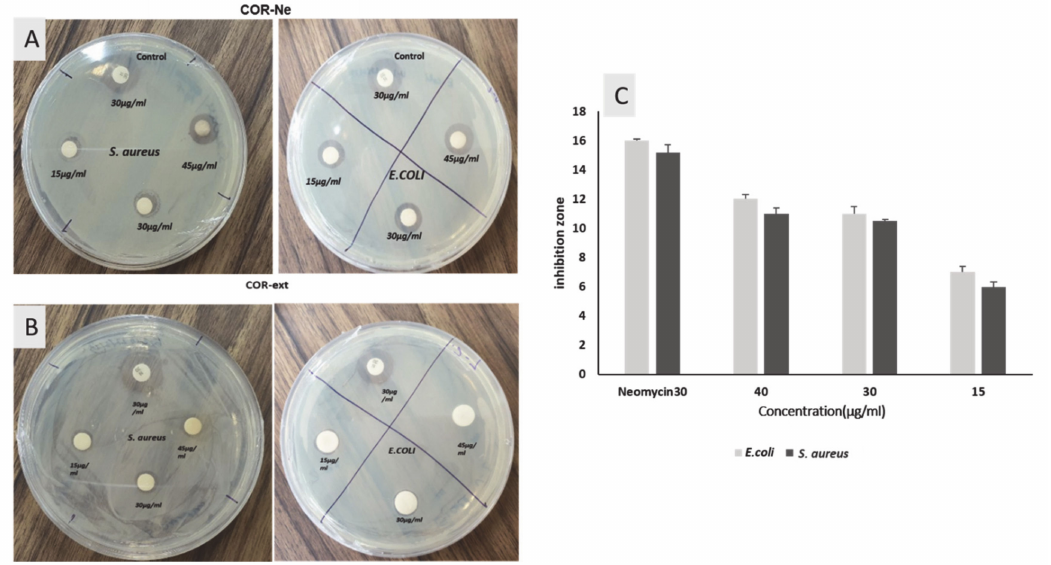
Figure 5. Antibacterial e ffi cacy analysis using disk di ff usion method against pathogenic bacteria E. coli and S. aureus: ( A ) Cordyceps nanoemulsion ( B ) COR-Ex, ( C ) bar chart for calculating inhibition zone of Cordyceps nanoemulsion against E. coli and S. aureus compared with commercial antibiotics Neomycin